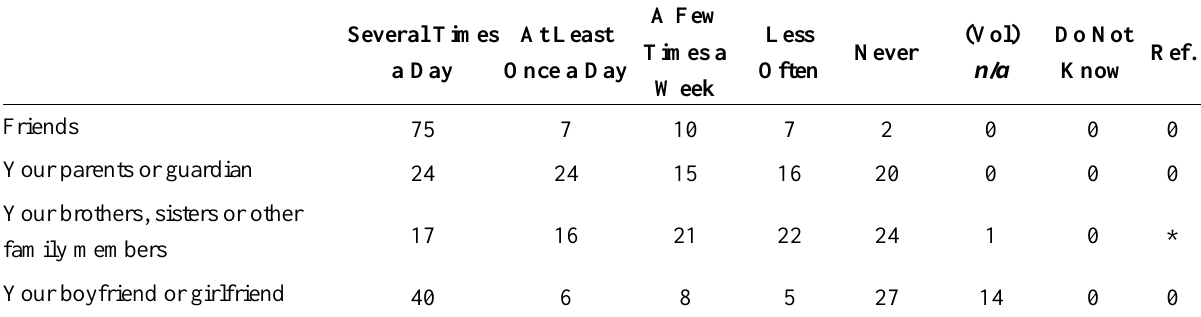
Table A4. How often do you send or receive text messages with [INSERT] on your cell phone… several times a day, at least once a day, a few times a week, less often or never? (Based on teen cell users who text message [ N = 552]).